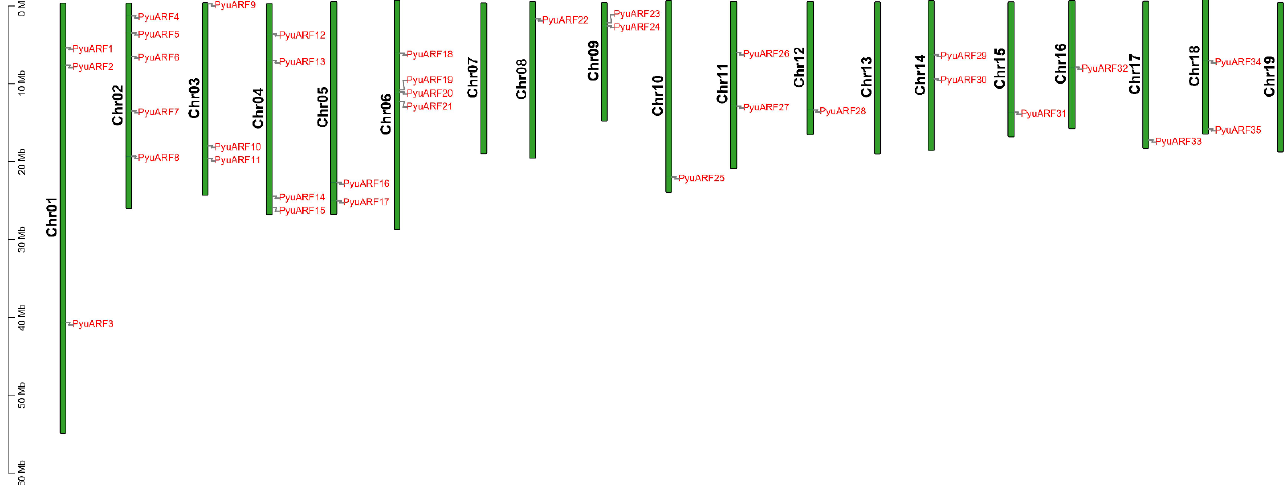
Figure 3. Synteny analysis of PyuARFs . The genes connected by red lines indicate ARFs that are homologous among the PyuARFs , and the genes connected by gray lines indicate other homologous genes.